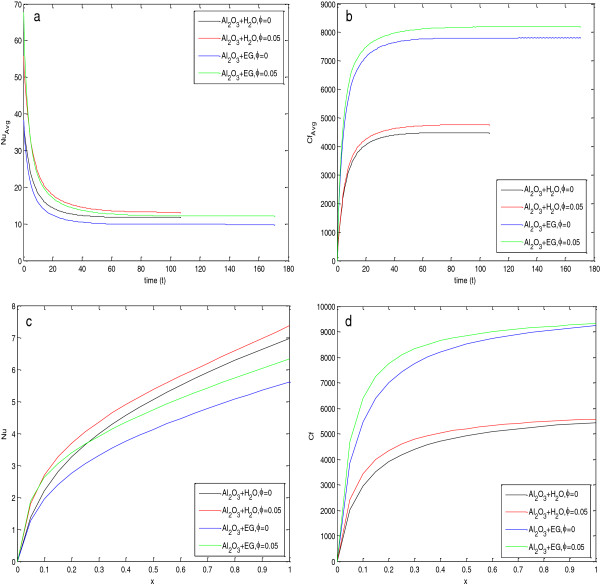
Comparison between(a,b,c,d)Al2O3+ H2O and Al2O3 + EG at 324 K.